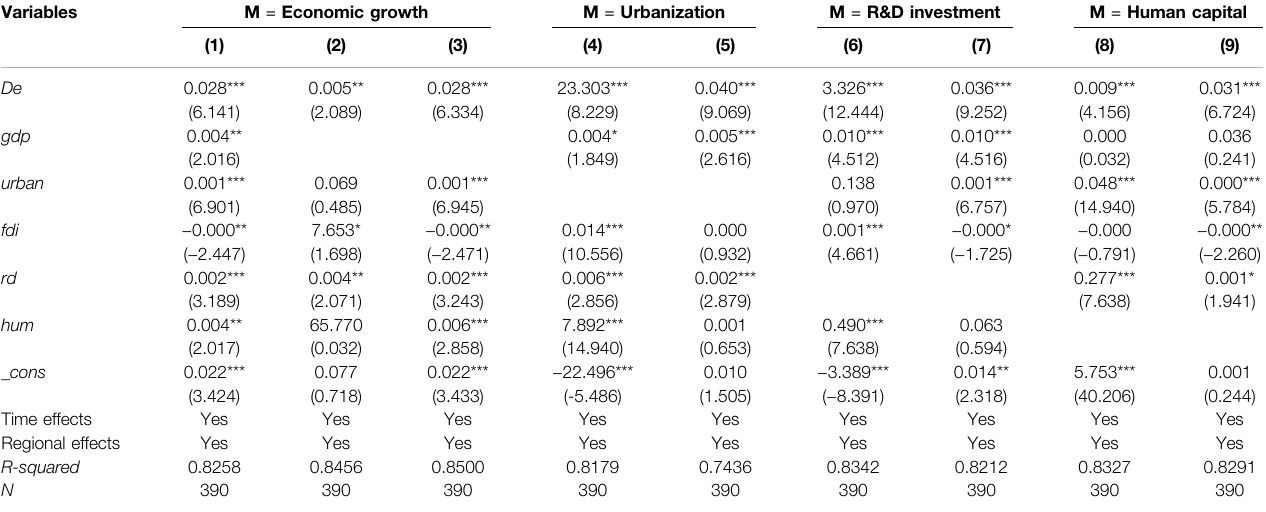
TABLE 8 | Mediation effect regression